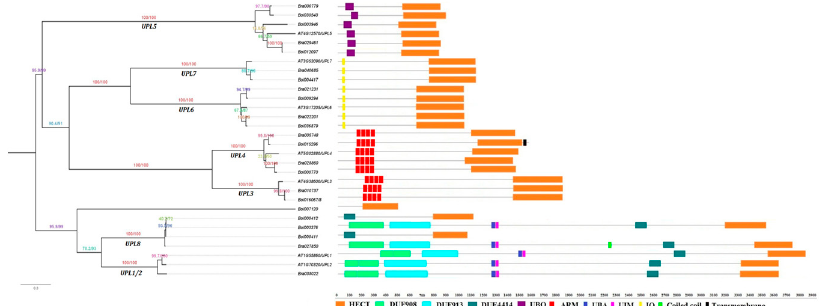
Figure4. Domainarchitecturesof B.rapa , B.oleracea and A.thaliana HECTproteinsandtheirphylogenetic Figure 4. Domain architectures of B. rapa , B. oleracea and A. thaliana HECT proteins and their relationships. PutativeadditionaldomainsineachHECTproteinwerepredictedbyusingtheonlinetools phylogenetic relationships. Putative additional domains in each HECT protein were predicted by of SMART (http: // smart.embl-heidelberg.de) and Interpro (http: // www.ebi.ac.uk / interpro / ) databases. using the online tools of SMART (http://smart.embl-heidelberg.de) and Interpro Each domain is represented by a colored box indicated at the bottom. DUF: Domain of unknown (http://www.ebi.ac.uk/interpro/) databases. Each domain is represented by a colored box indicated function; UBQ: Ubiquitin homologues; ARM: Armadillo repeats; UBA: Ubiquitin-associated domain; at the bottom. DUF: Domain of unknown function; UBQ: Ubiquitin homologues; ARM: Armadillo UIM: Ubiquitin-interacting motif; IQ: IQ short calmodulin-binding motif. The scale bar at the bottom repeats; UBA: Ubiquitin-associated domain; UIM: Ubiquitin-interacting motif; IQ: IQ short (right side) indicates the lengths of calmodulin-binding motif. The scale bar at the bottom (right side) indicates the lengths of proteins.